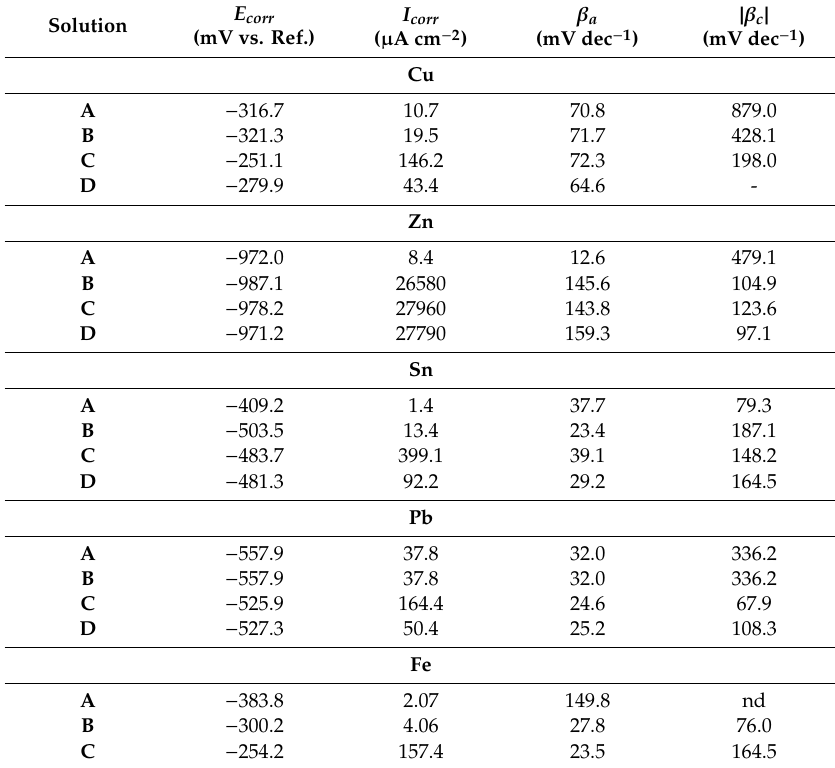
Table 1. Corrosion kinetic parameters for metals in di ff erent bromide-based electrolytes.